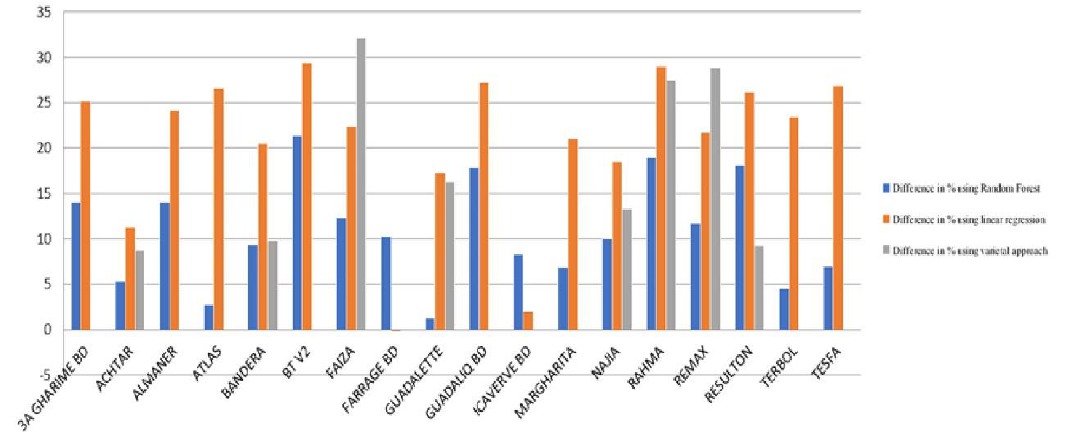
Figure 13. Difference in % between actual and predicted wheat yield using both varietal and general approaches. Table 8. Predicted wheat yield using varietal approach.